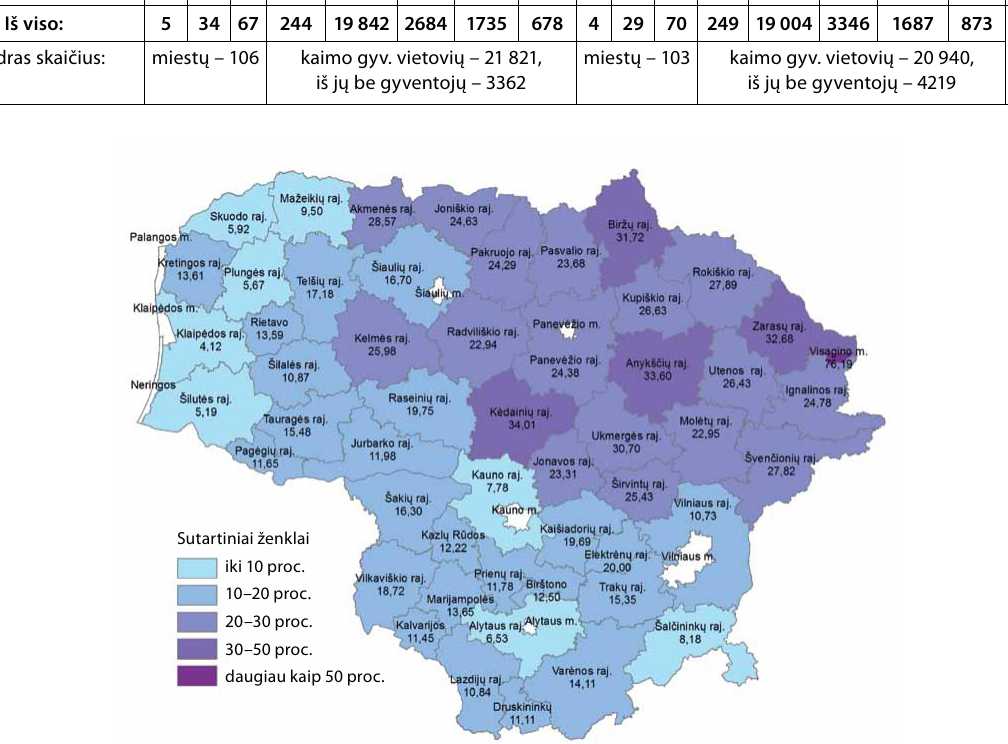
fig. 1. The part of rural settlements wich are without habitants (%) in municipalities in 2011 (according analysis of lithuania statistics department results of Census of population and housing in 2011 of the republic of